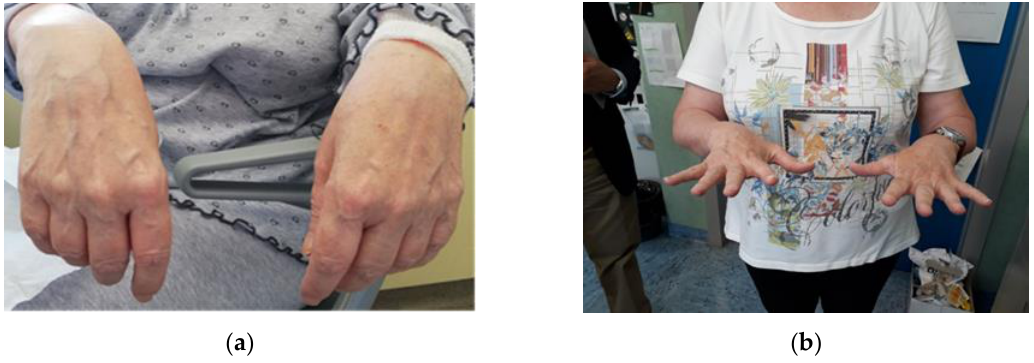
Figure 1. In July 2018, the patient’s hands were extremely weak and she could not extend her hand on the wrist ( a ). Nine months later, in April 2019, she obtained complete resolution of the neuropathy as a result of chelation therapy and rehabilitation ( b ).